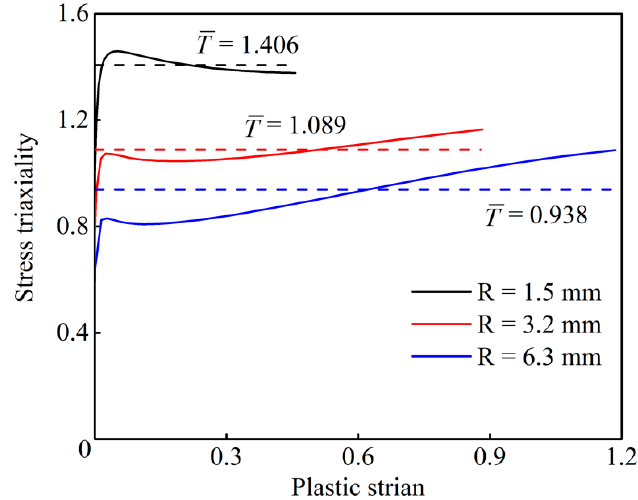
Figure 11. Equivalent plastic strain versus stress triaxiality for X80 pipeline steel SNT tensile speci- mens (M1, M3, and M5).